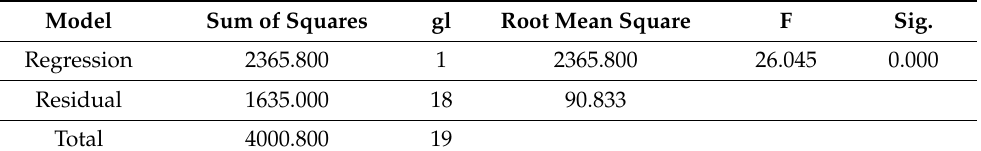
Table 7. ANOVA of model a .